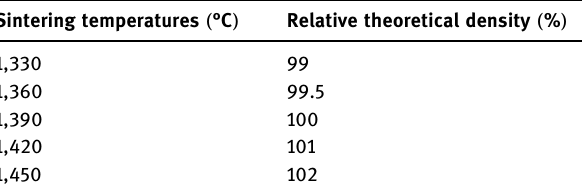
Table 1: Relative density of samples at di ff erent sintering temperatures Sintering temperatures ( °C )